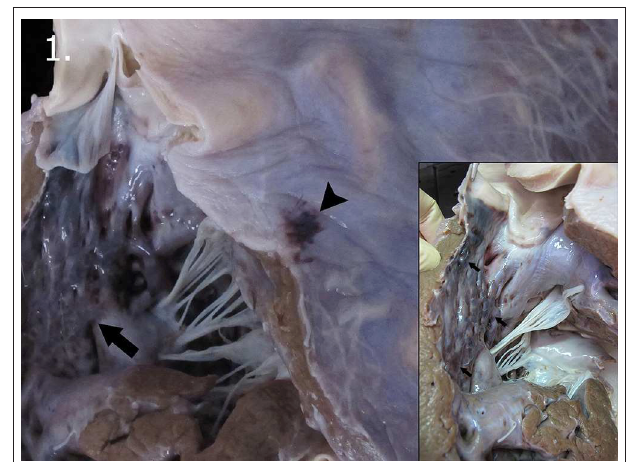
FIGURE 1 | Macroscopic vascular changes observed in the heart. Subepicardial (arrow head) and subendocardial hemorrhage (arrow) in the left ventricle. Detail of the subendocardial hemorrhages present in the left ventricle